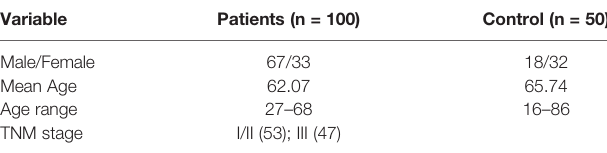
TABLE 6 | Clinicopathological characteristics of the CRC patients (n =